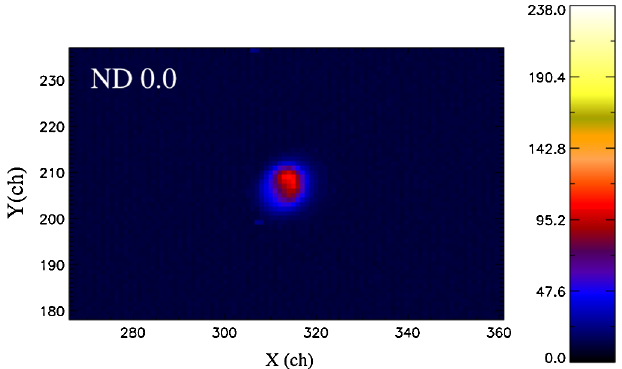
FIG. 8. (Color) An example of VLD0 OTR data with the 120-A beam and 450-pC micropulse with ND 0.0.